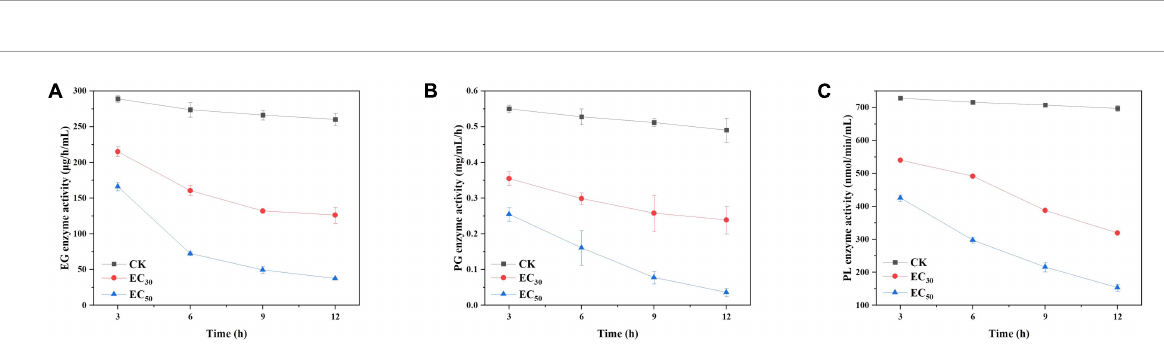
FIGURE7 Effects of JEO on the enzyme activities of EG (A) , PG (B) , and PL (C) secreted from B. cinerea following treatment with different concentrations of JEO (0 as control, EC 30 , and EC 50 ). The bars represent the standard error of the mean ( n = 3). EG, endoglucanase; JEO, juniper essential oil; PG, polygalacturonase; PL, pectin